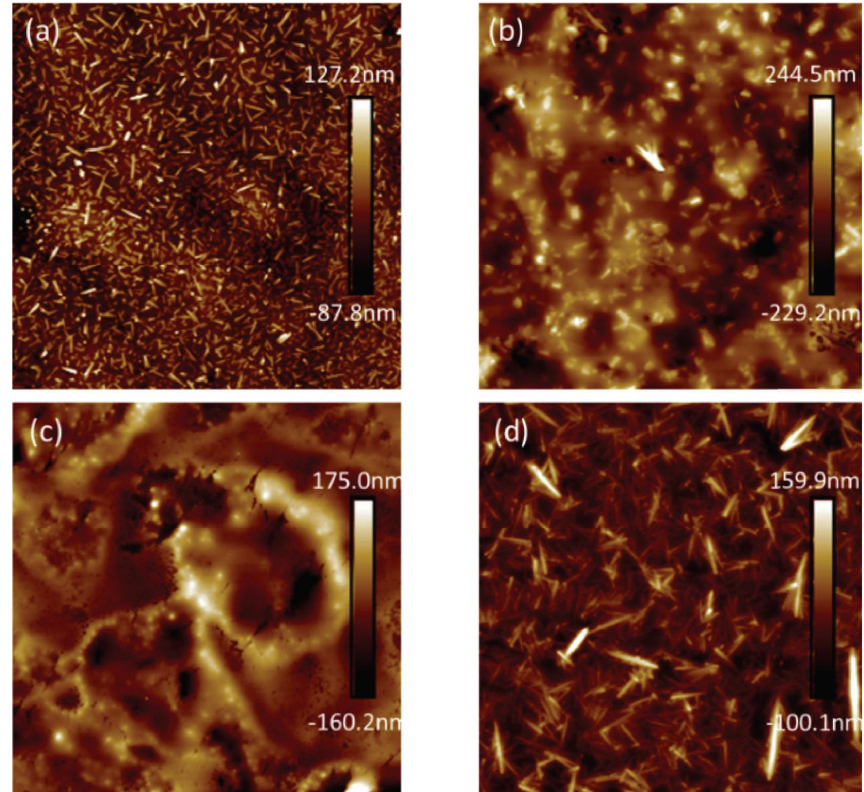
Figure 12: AFM images of T770 modifed asphalt. (a) 76.25h. (b) 152.5h. (c) 228h. (d) 305h.